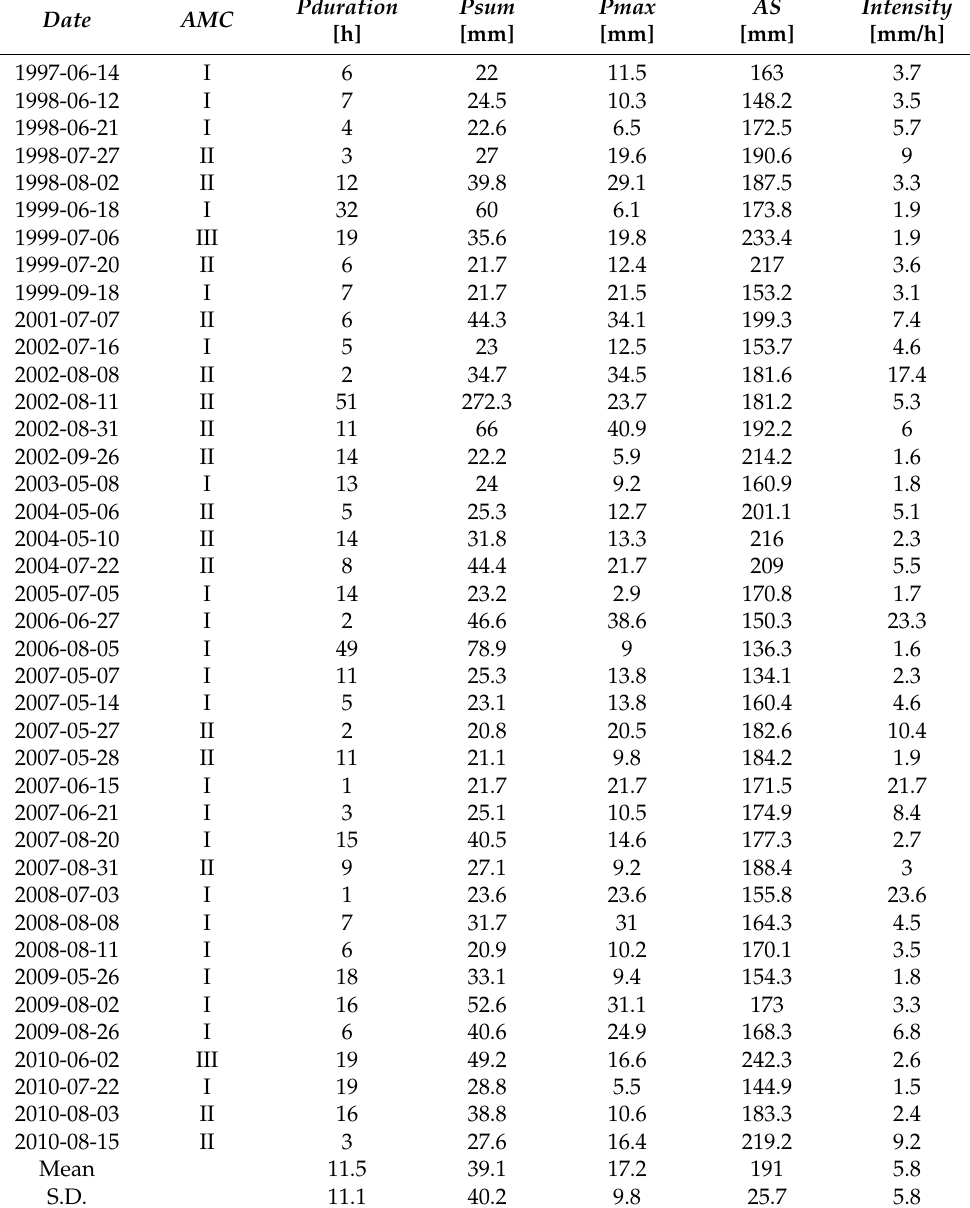
Table 1. Selected rainfall event characteristics with Psum ≥ 20 mm (AMC = antecedent soil moisture condition categorized into three classes, with I indicating wet and III indicating dry; Pduration = rainfall event duration; Pmax = precipitation peak; AS = antecedent soil moisture as an absolute value in